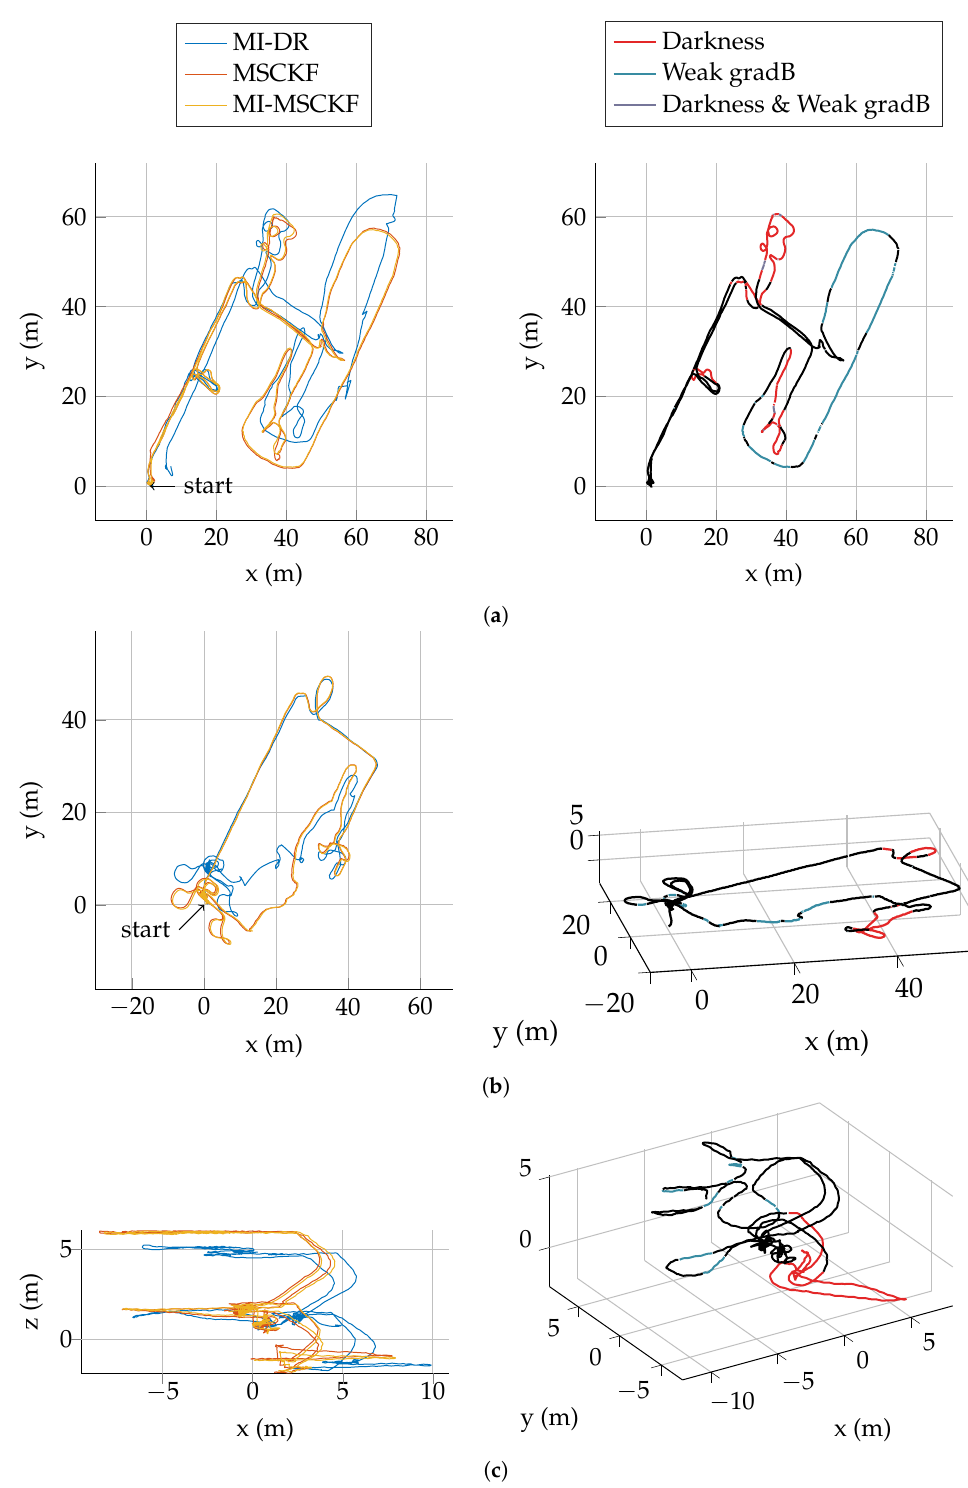
Figure 9. Summary of trajectories on the remaining sequences of the dataset. ( Left ): Estimate of the three configuration of our filter. ( Right ) Color coded MI-MSCKF trajectory showing areas of weak gradient and weak illumination. ( a ) Traj1 Length: 180 ∼